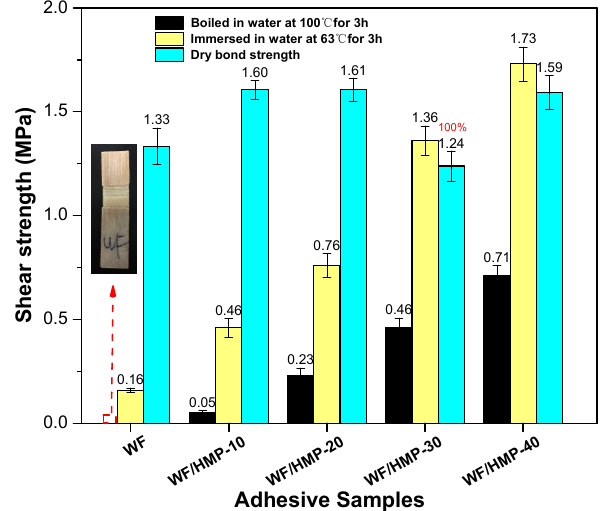
ff erent adhesive